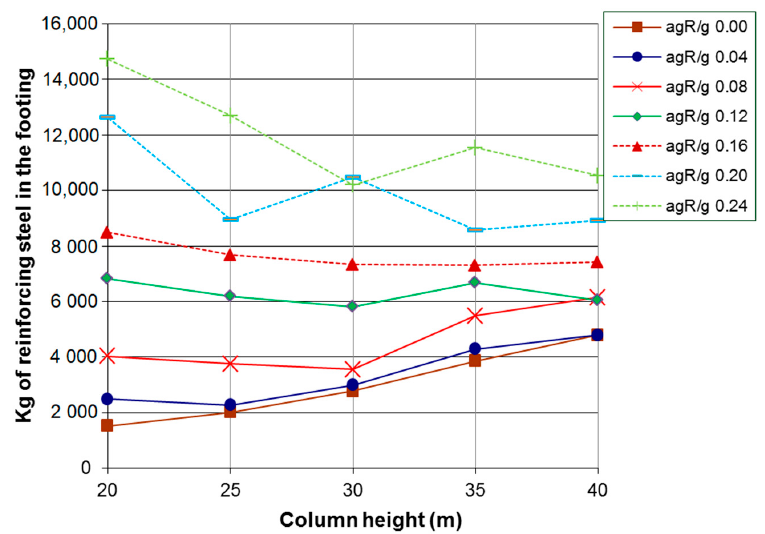
Figure 14. Steel reinforcement in the footing versus height of the column.